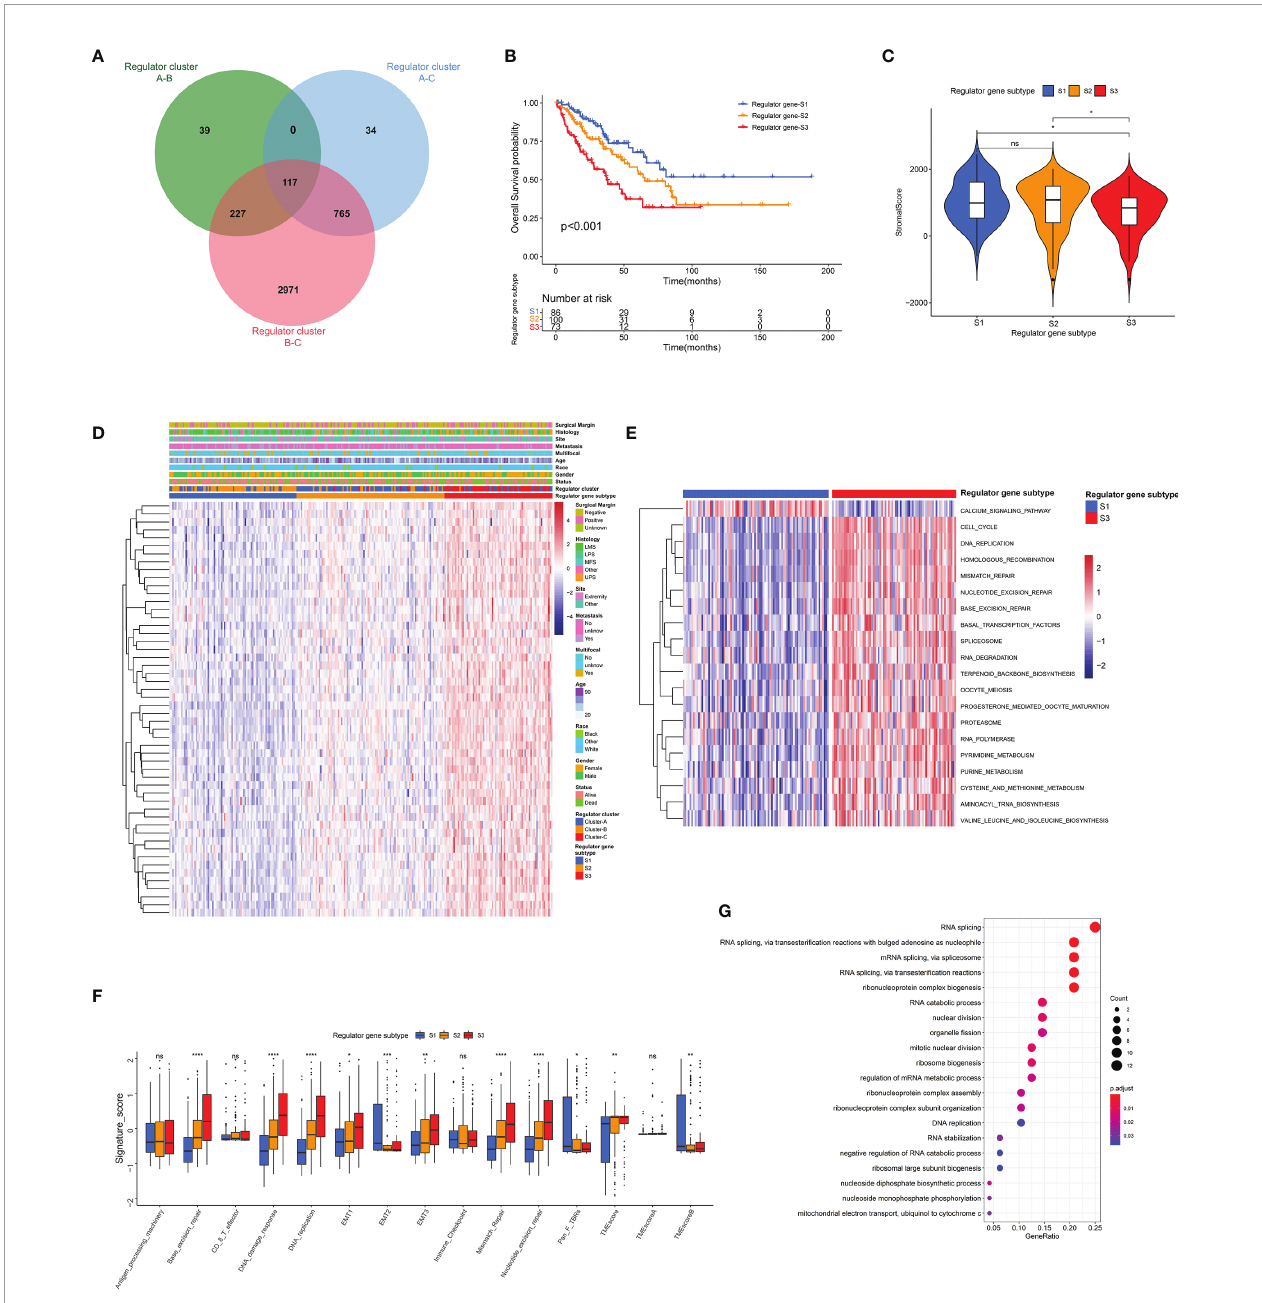
FIGURE 5 | Identi fi cation of distinct genomic subtypes and TME cell in fi ltration. (A) Venn diagram showing the overlapping of RNA modi fi cation regulator-related DEGs. (B) The OS curve comparing survival of the TCGA-SARC cohort in Regulator gene S1 (blue), Regulator gene S2 (orange), and Regulator gene S3 (red). (C) Differences in stromal score among three regulator gene subtypes in the TCGA-SARC cohort. (D) The unsupervised clustering analysis of the 54 overlapping DEGs in the TCGA-SARC cohort. (E) The GSVA illustrating pathway enrichment among distinct regulator gene subtypes. (F) Differences in TMB signatures among three regulator gene subtypes in the TCGA-SARC cohort. (G) GO enrichment analysis of the 54 overlapping DEGs. ns, p ≥ 0.05; *, 0.01 ≤ p < 0.05; **, 0.001 ≤ p < 0.01; ***, 0.0001 ≤ p < 0.001; ****, p <